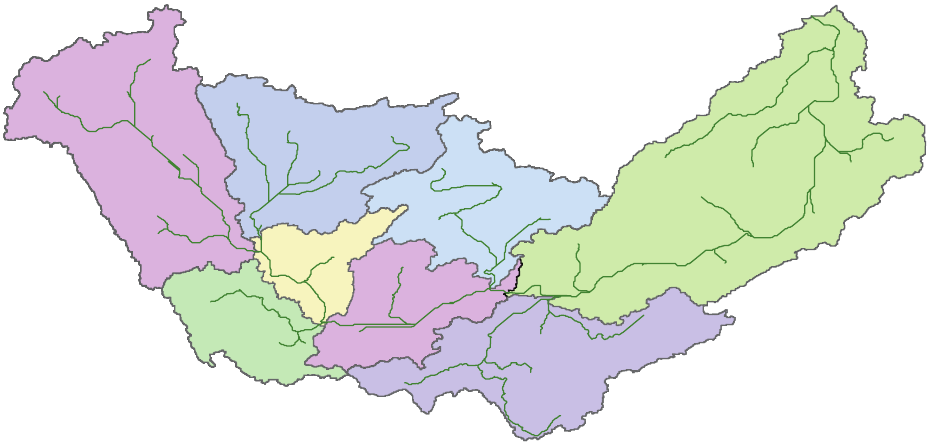
Figure 2: Subdivision of the study area.